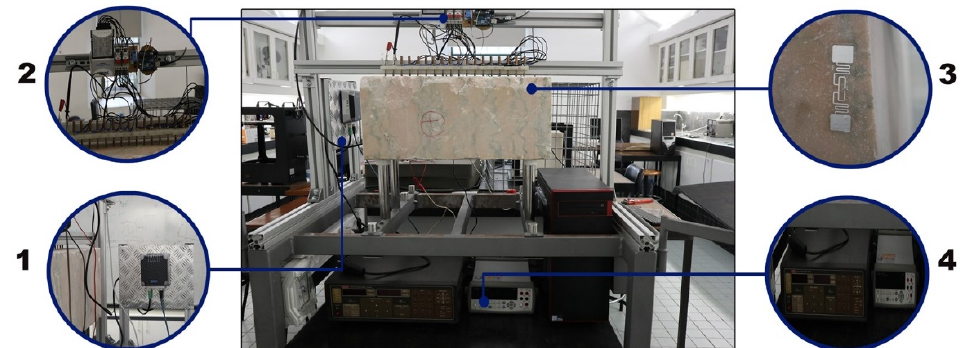
Figure 10. Schematic layout of RFID-System used in the Block-Parameter Tests.